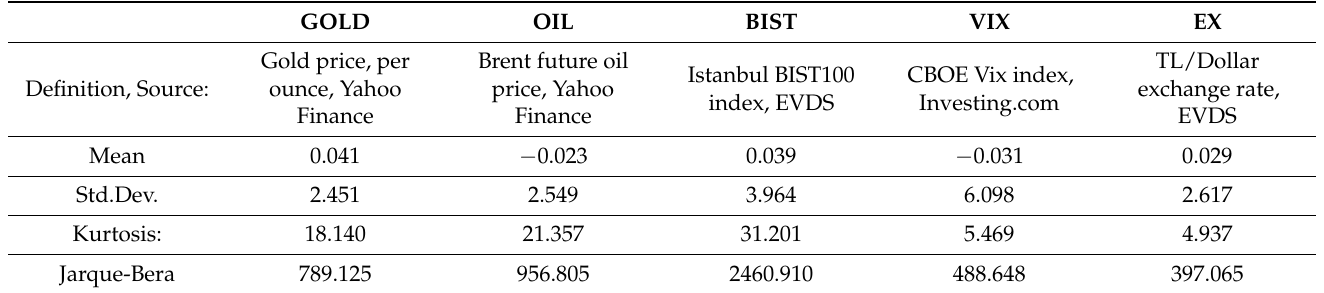
Table 1. Descriptive statistics and data